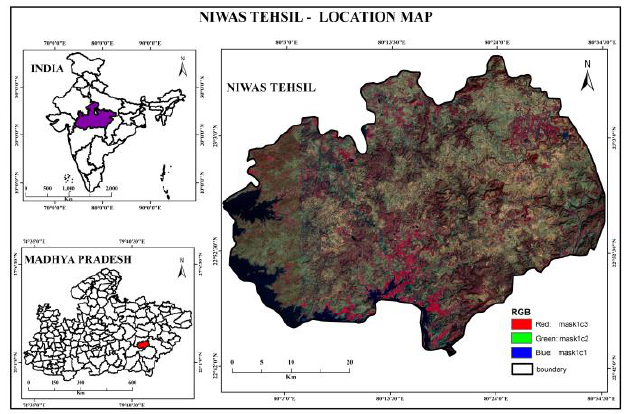
Figure 1. Niwas tehsil – Location